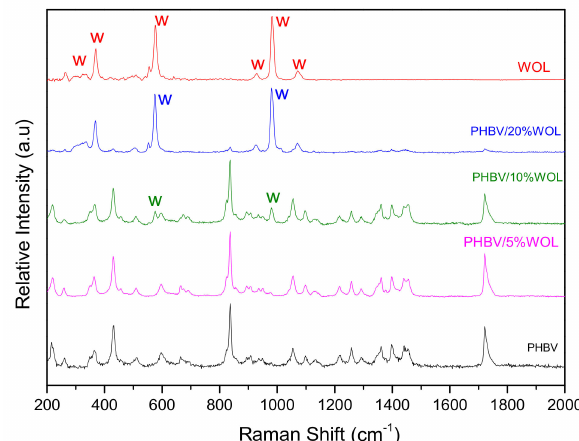
Figure 3. Raman spectra of WOL powder and neat poly(3-hydroxybutyrate- co -3-hydroxyvalerate) (PHBV), PHBV / 5%WOL, PHBV / 10%WOL and PHBV / 20%WOL